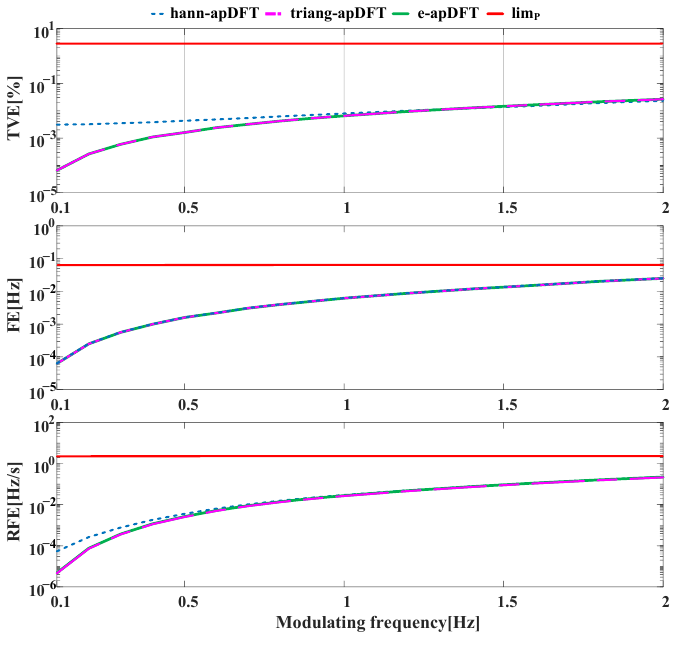
Figure 10. Phase modulation test.